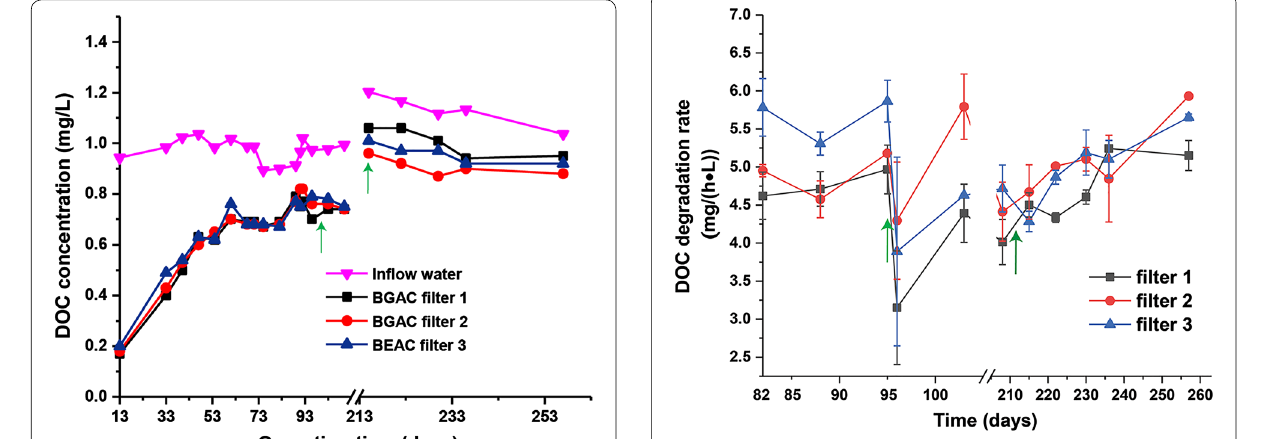
Fig. 2 Effect of backwashing and flow rate on microbial degradation rates in BAC filters. Data depict means and standard deviations of three parallel incubations for RIL. Arrows indicate the backwashing at Day 96 and changing of flow rates at Day 208. Filters 1 and 2 are filled with granular activated carbon whereas filter 3 is filled with extruded activated